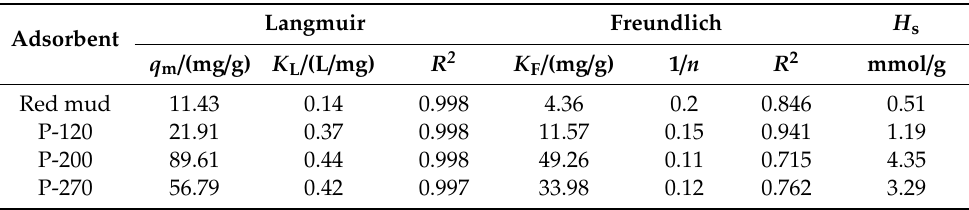
Figure 6. Adsorption isotherm of Zn 2+ on red mud, P-120, P-200, and P-270. Experimental conditions: equilibrium time: 12 h, P-200 dosage: 0.01 g, initial pH: 4. Table 1. Parameters of the isotherm models and the surface sites concentrations of red mud and the obtained adsorbents.